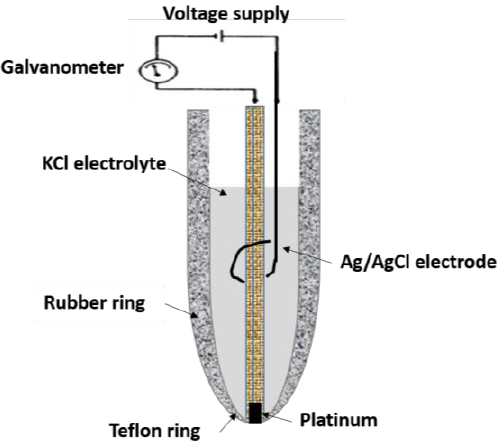
Figure 2. The first oxygen electrode developed by Clark in 1962.